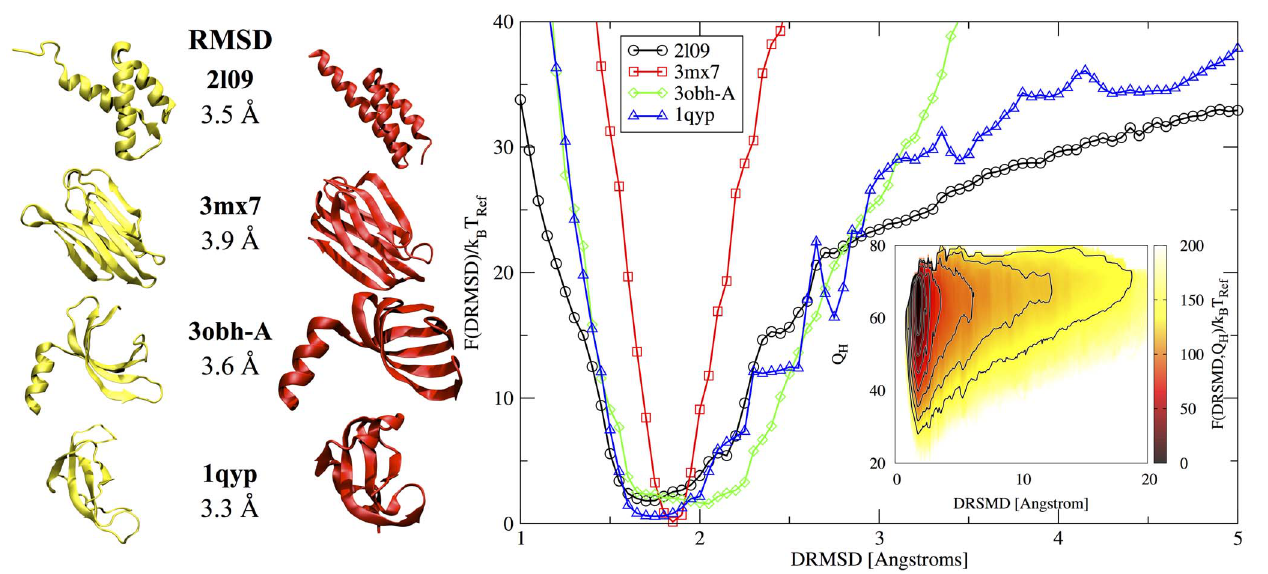
Figure 4. Folding free energy landscape F (DRMSD)/ k B T Ref as a function of DRMSD of the four designed proteins (PDB ids 2l09, 3mx7, chain A of 3obh, and 1qyp). All profiles have a global minimum around 1.5 and 2 A˚ DRMSD with a smooth funnelled shape. Due the approximations present in the model and to thermal fluctuations is shifted with respect to DRMSD ~ 0 (note that to the value DRMSD ~ 0 of each profile will correspond a different native structure). Because of the definition of DRMSD, the smaller the value the fewer are the possible structures that can have this value of DRMSD. Ultimately, DRMSD ~ 0 is possible only for the target structure itself. The funnelled profiles with single minimum implies that both an ensemble of arrested structures and a single alternative fold are less stable compared to the desired configuration. In the bottom right inset we plot the folding free energy landscape F ( DRMSD , Q H ) = k B T Ref for 3mx7 as a function of both the DRMSD and the number of hydrogen bonds Q H , to give a visual example of the funnel nature of the folding landscapes. On the left we compare the experimentally determined structures (in yellow) with a typical folded conformation selected as the sampled configurations with the lowest energy at the free energy minimum (in red). The RMSD value is indicated in the middle. The structures were aligned using the RMSD calculator tool in VMD [52], while the secondary structure elments where identified with STRIDE